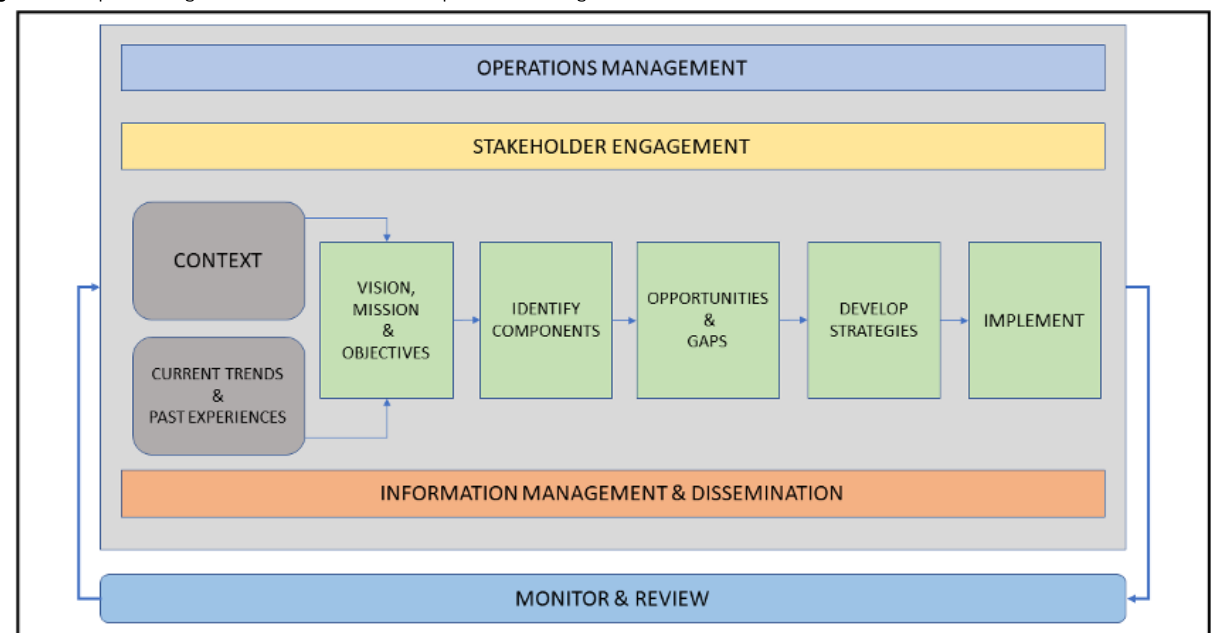
Figure 5. Proposed integrated eHealth framework for pandemic